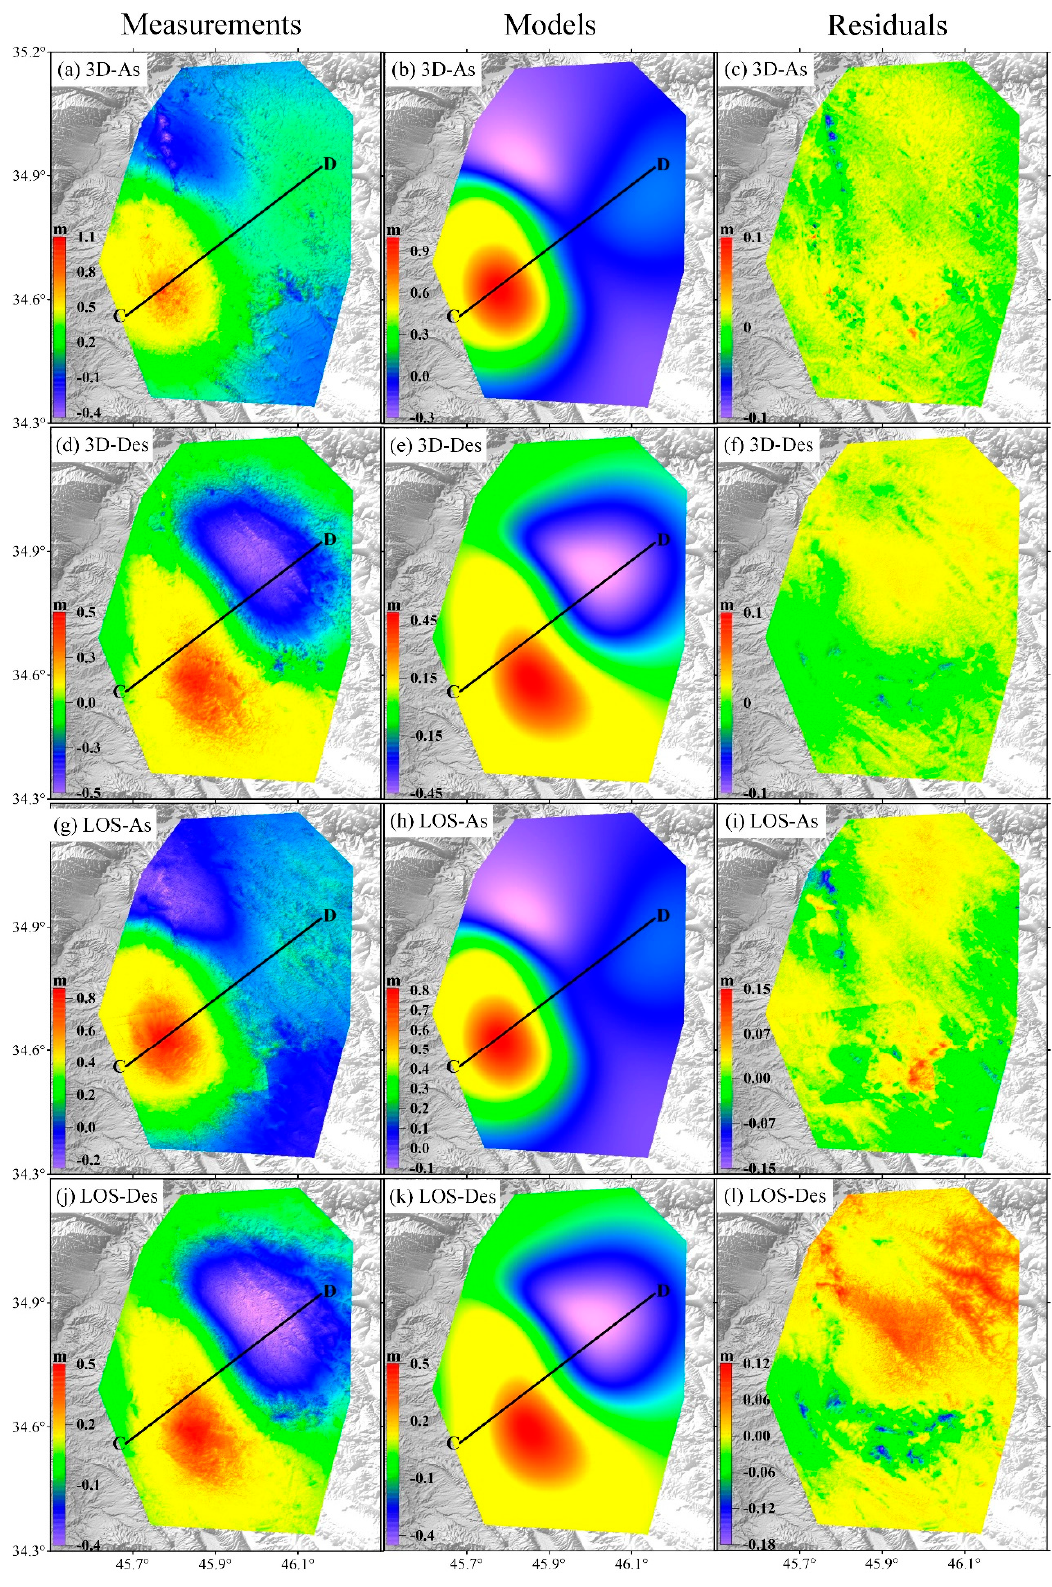
Figure 7. The measurements, models and residuals maps. ( a )–( f ) derived from the 3D coseismic deformation data sets. ( g )–( l ) derived from the LOS coseismic deformation data sets. The black line is the profile CD.